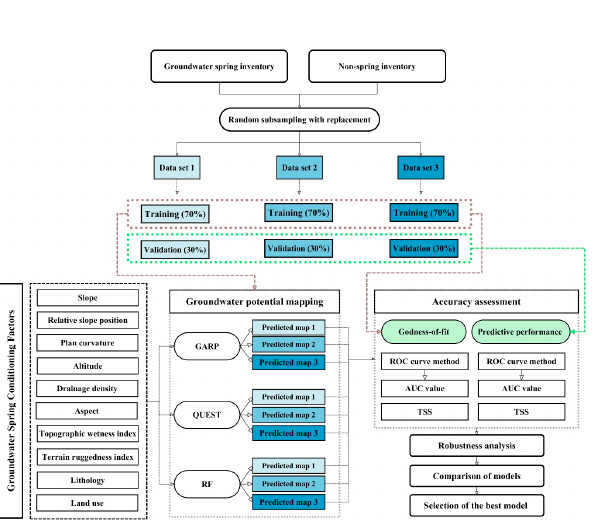
Figure 2. Methodological flowchart of the study. GARP, Genetic Algorithm for Rule-Set Production; QUEST, Quick Unbiased Efficient Statistical Tree; RF, Random Forest; ROC, receiver operating characteristics; AUC, area under the receiver operating characteristic curve; TSS, true skill statistic.